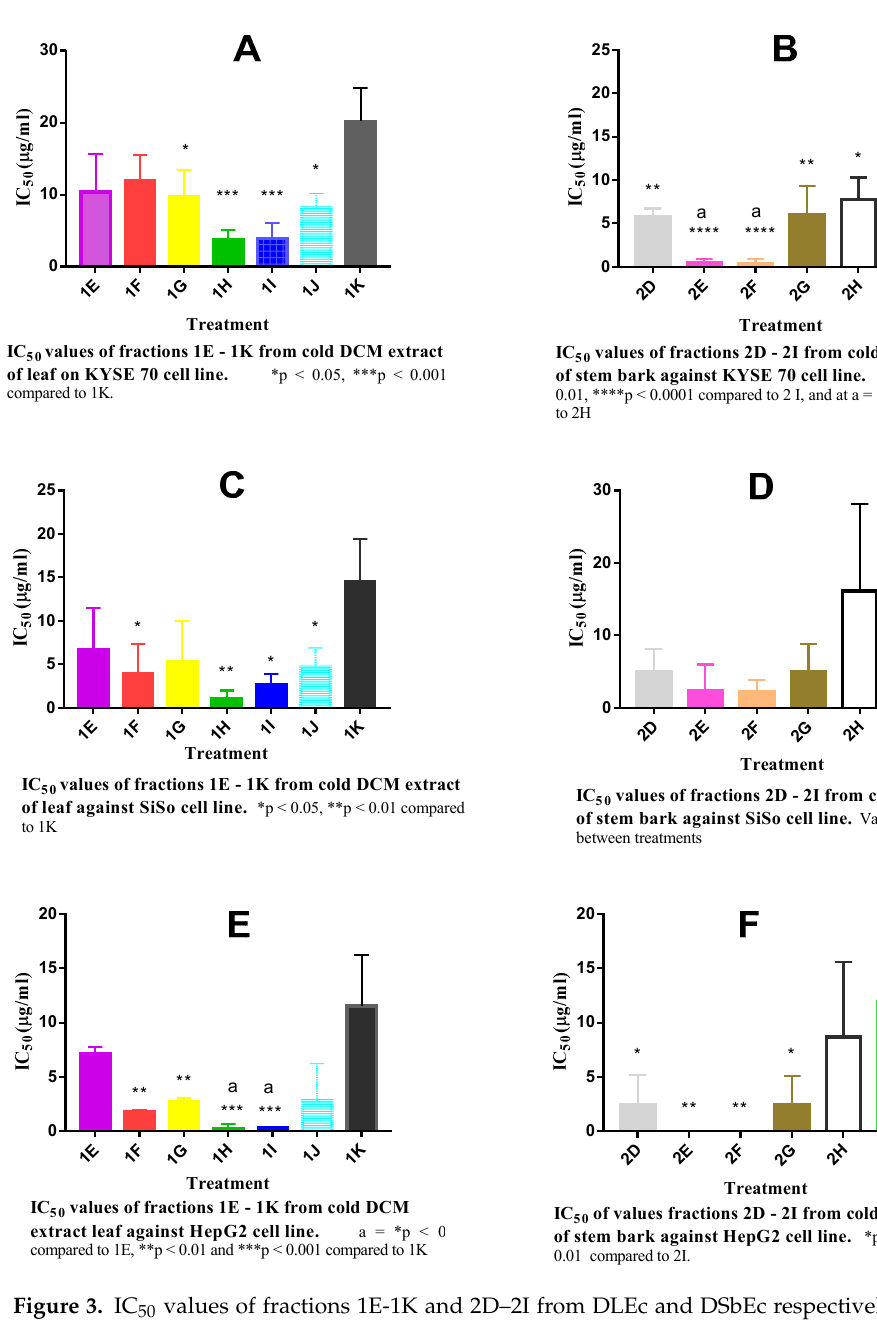
Figure 3. IC 50 values of fractions 1E-1K and 2D–2I from DLEc and DSbEc respectively against the cell lines. ( A , B ) = KYSE 70 cell line, ( C , D ) = SiSo cell line and ( E , F ) = HepG2 cell line. Values are mean ± SEM ( n = 3) one-way ANOVA (Tukey’s multiple comparisons test).